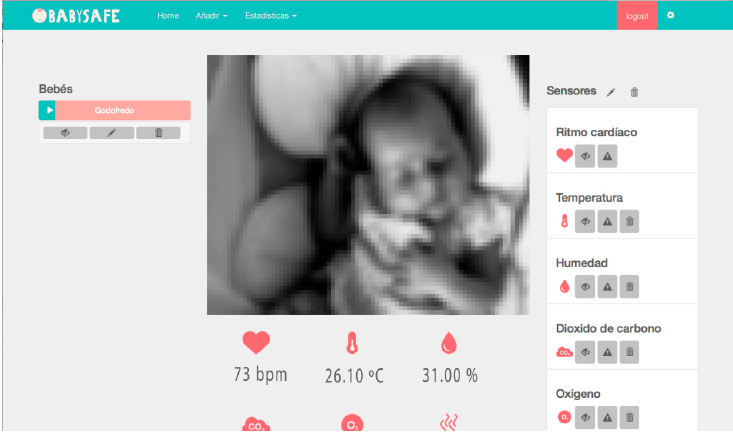
Figure 9. The developed web application. The image of the child has been distorted for privacy reasons.